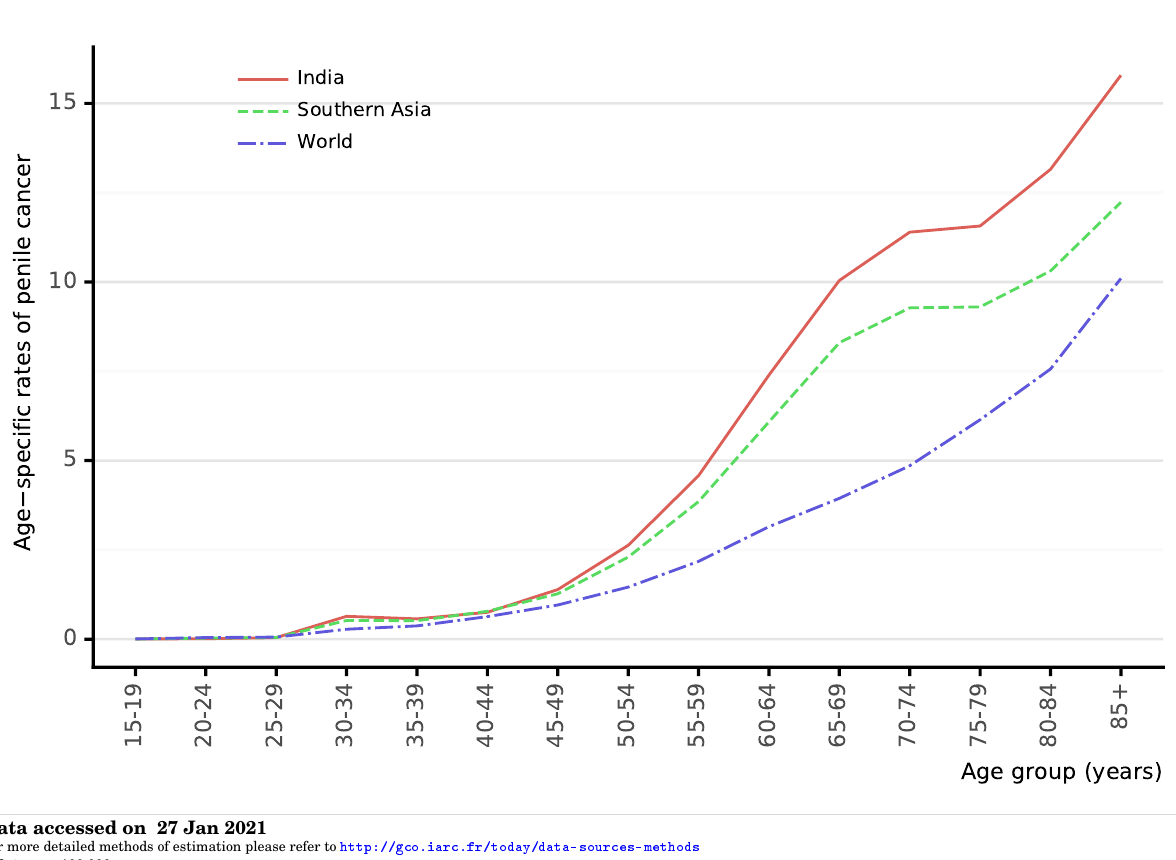
Figure 89: Comparison of age-specific penile cancer incidence rates in India, within the region, and the rest of